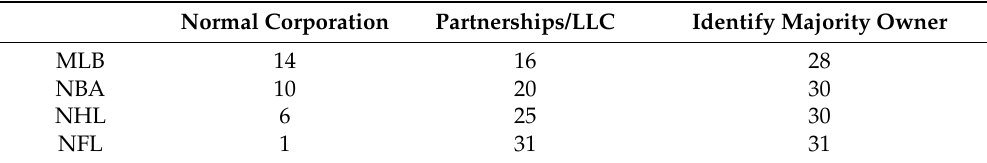
Table 1. Ownership structures in North American professional sports leagues, 2018.